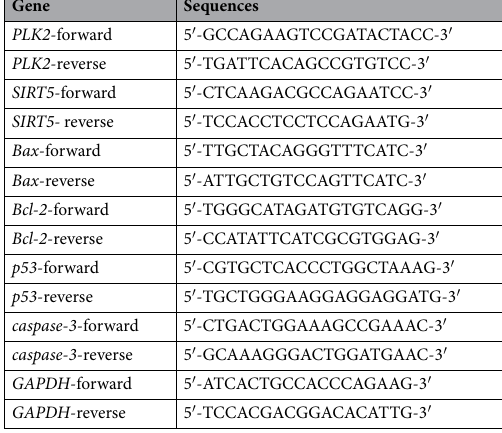
Table 1. Primes sequences used in this study.